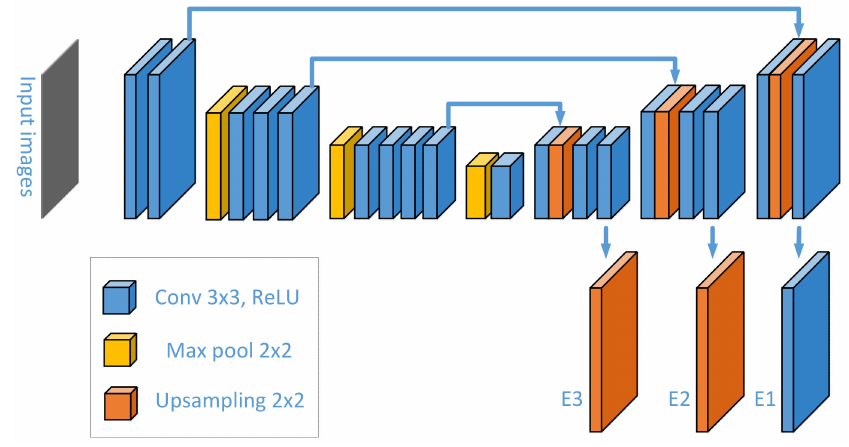
Figure 2. Encode-decoder